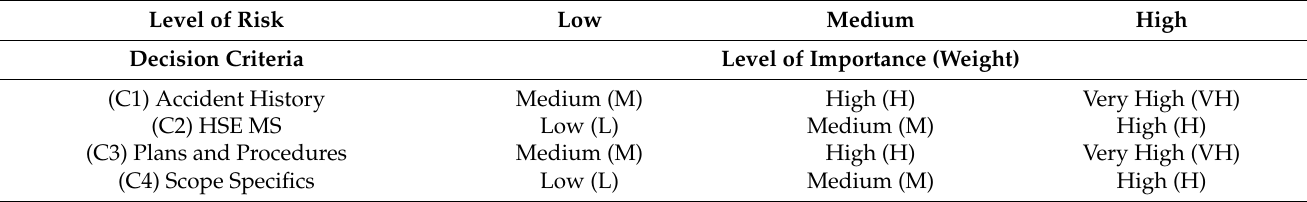
Table 6. Correlation between the operation risk level and the level of importance of each decision criterion. Level of